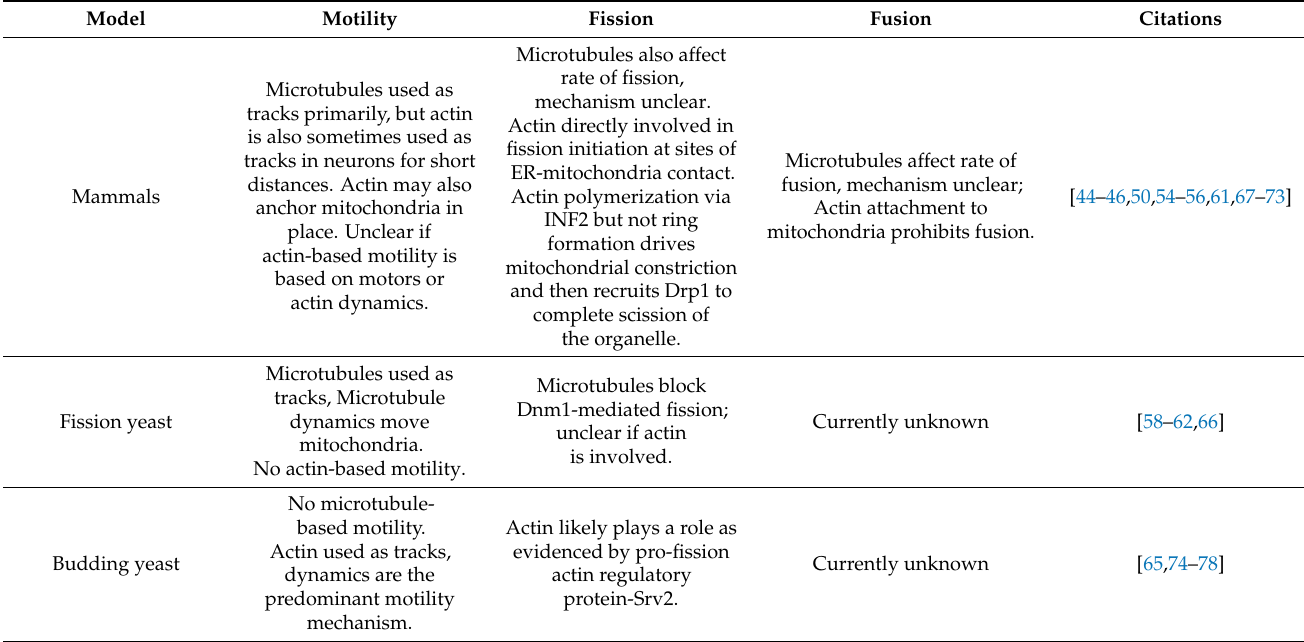
Table 2. Summary of what is currently known about the cytoskeleton’s involvement in mitochondrial dynamics in mammals, fission yeast, and budding